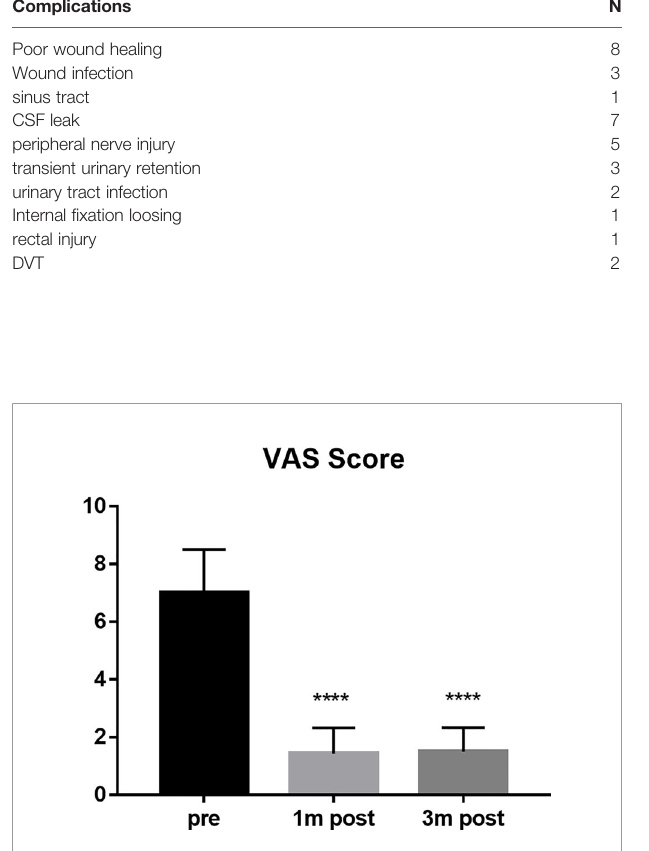
FIGURE 2 | VAS score compared the scores of the patients pre, 1 month post and 3 months post operation. ****P < 0.0001.